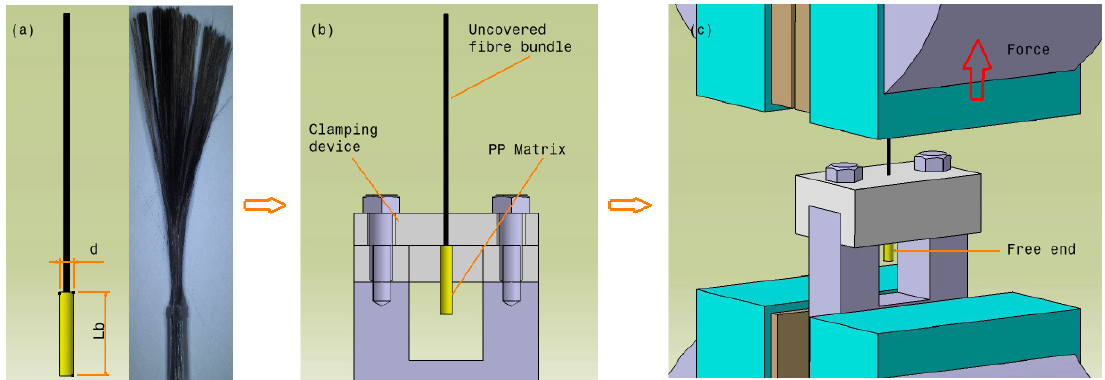
Figure 6. Pull-out testing system: ( a ) test specimen, ( b ) clamping position and ( c ) test position.